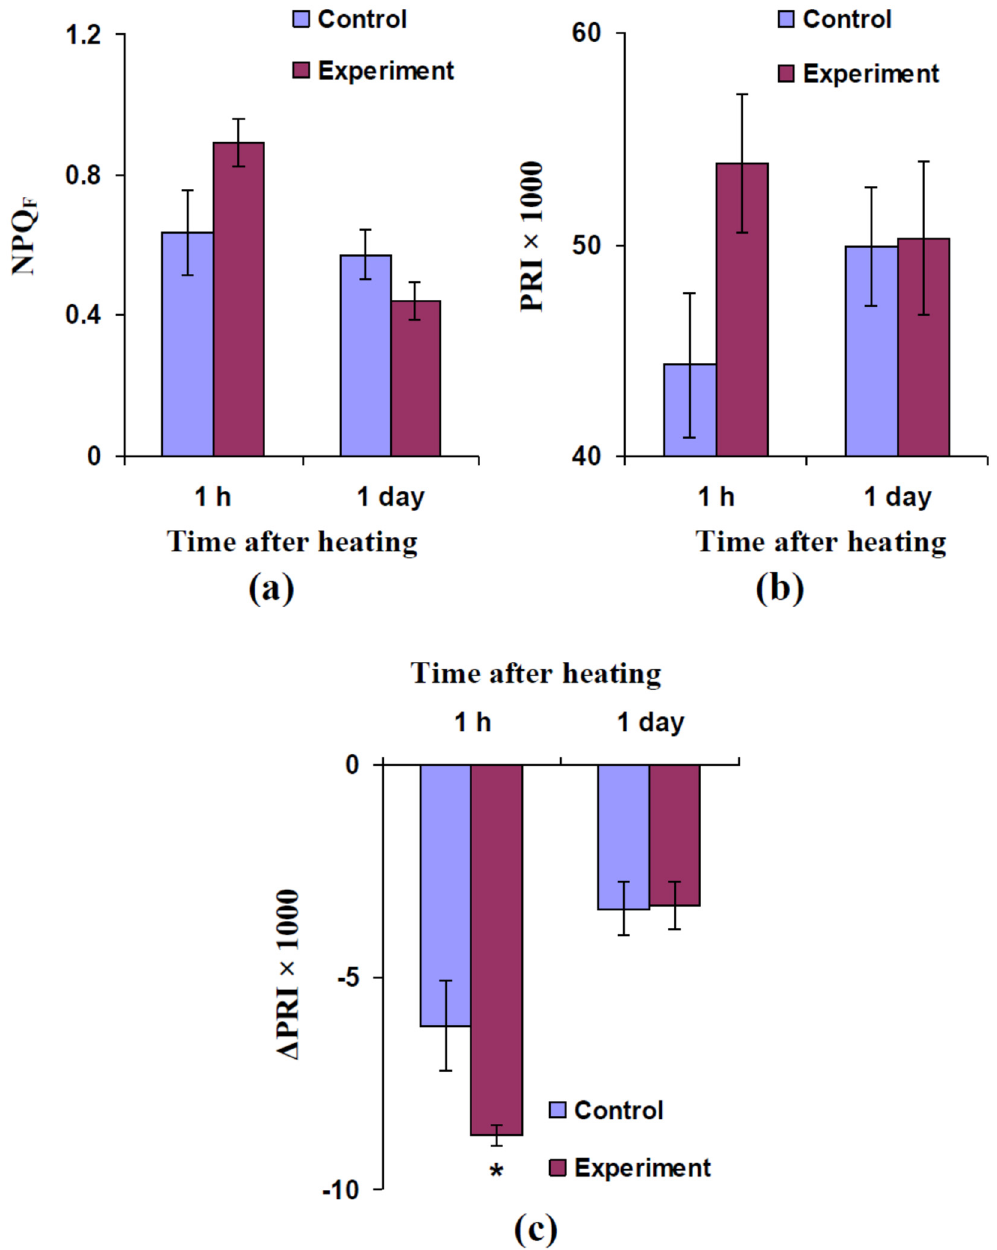
Figure 8. The energy-dependent component of the non-photochemical quenching of fluorescence (NPQ F ) ( a ), the absolute value of PRI ( b ), and its change ( Δ PRI) ( c ) in leaves of pea seedlings in 1 h and 1 day after short-term heating ( n = 12). Measurements were initiated after 15 min dark adaptation. Duration of AL action (617 nm, 280 μ mol m − 2 s − 1 ) was 10 min followed by 5 min dark interval. The absolute value of PRI was measured before termination of illumination. Δ PRI was measured as difference between PRI measured before termination of the illumination, and the initial PRI measured before initiation of the illumination. The experimental seedlings were heated for 30 min at 46 °C; control plants were not heated. * indicates that experimental and control parameters significantly differed ( p < 0.05). n is number of repetitions. Bars show standard errors.